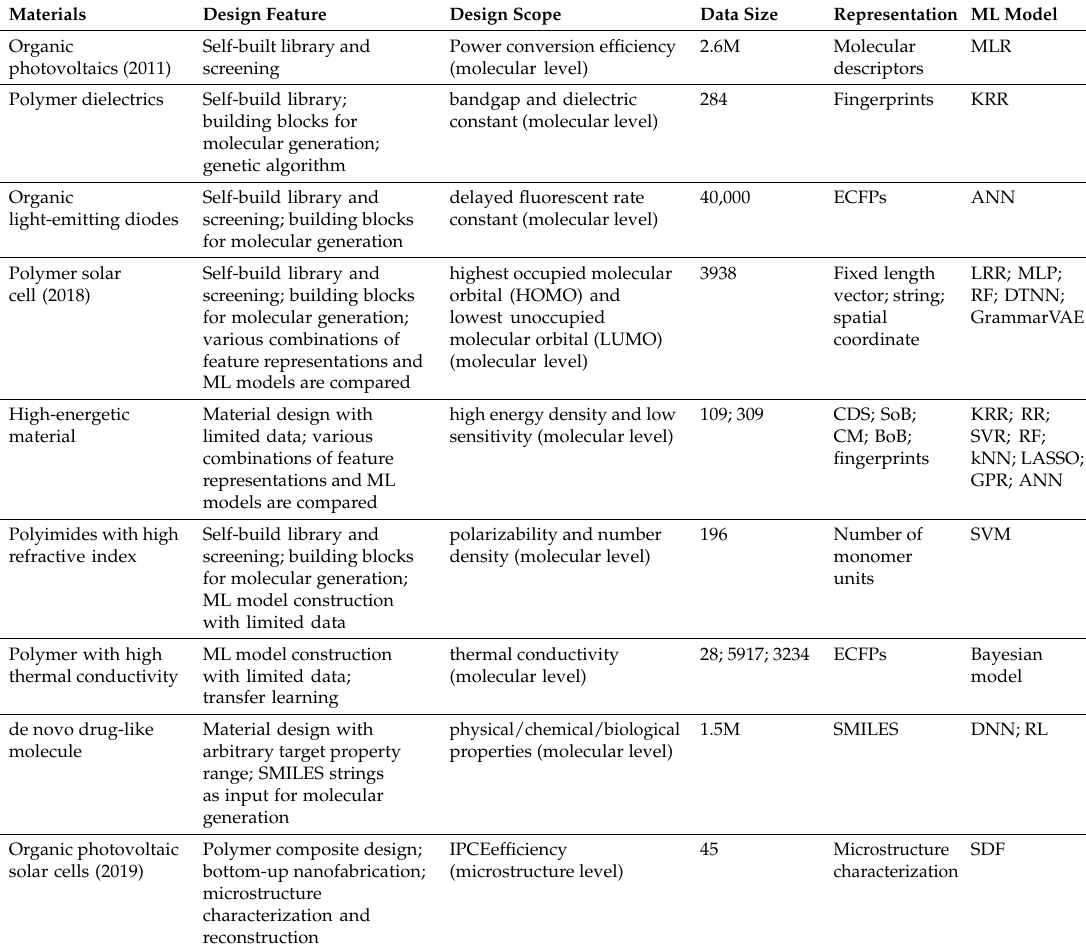
Table 1. Summary of the nine ML-guided materials design